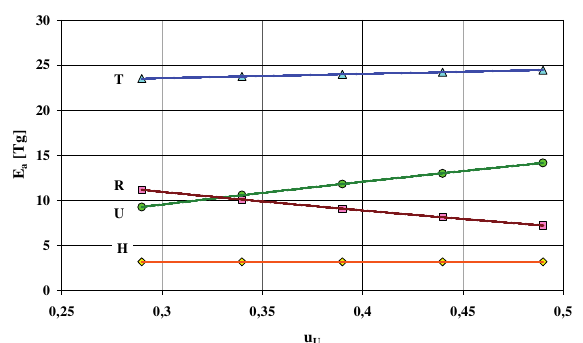
Fig. 10. Dependence of the national annual emission of nitrogen oxides from passenger cars upon the road length travelled under the following model traffic conditions: U – urban, R – rural, H – on highways and expressways as well as T – under all conditions